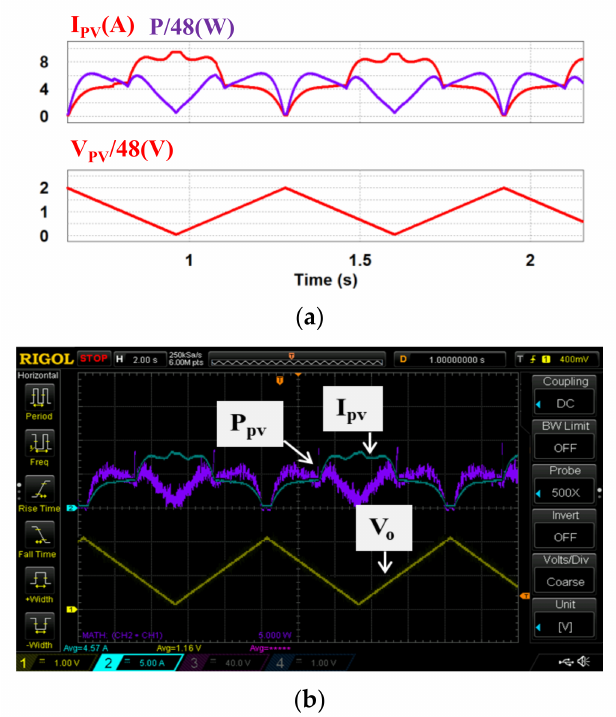
Figure 15. Output results of proposed PV emulator under S = 500 & 1000 with practical measured PV data: ( a ) simulated power and current outputs and PV voltage; ( b ) implemented power and current outputs and PV